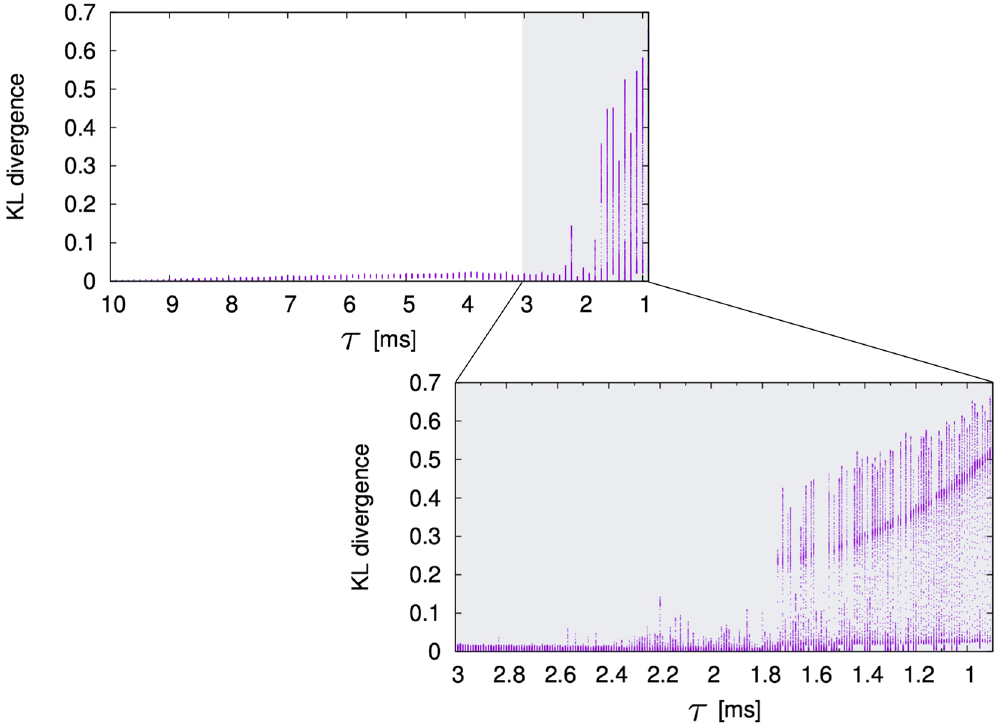
Figure 5. Change of the KL divergence between the probability distribution of the synaptic weights when τ = 10 [ms] with t = 1,000 [s] (reference distribution) and the probability distribution of each τ with each second. The horizontal axis is the value of parameter τ , and the vertical axis is the KL divergence. Values of the KL divergence are plotted for several temporal indexes simultaneously in the vertical